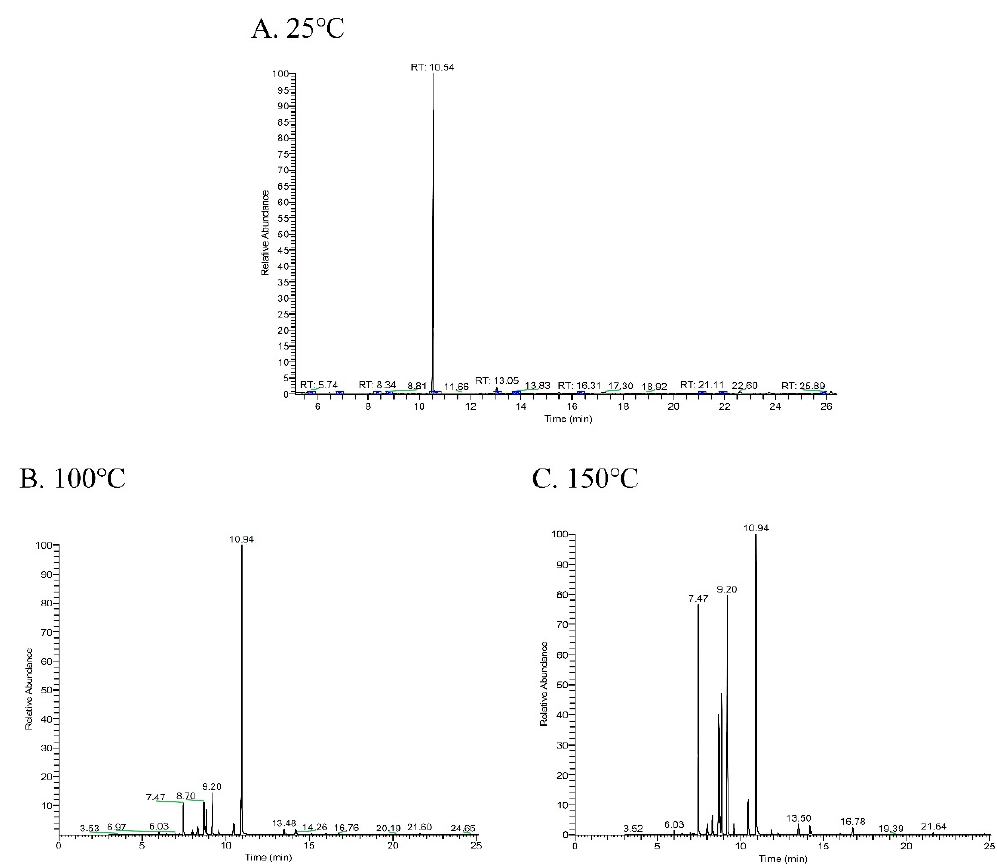
Figure 1. Gas chromatogram of linalool-chemotype C. osmophloeum leaf oil after thermal degradation. ( A ) 25 °C; ( B ) 100 °C; ( C ) 150 °C.